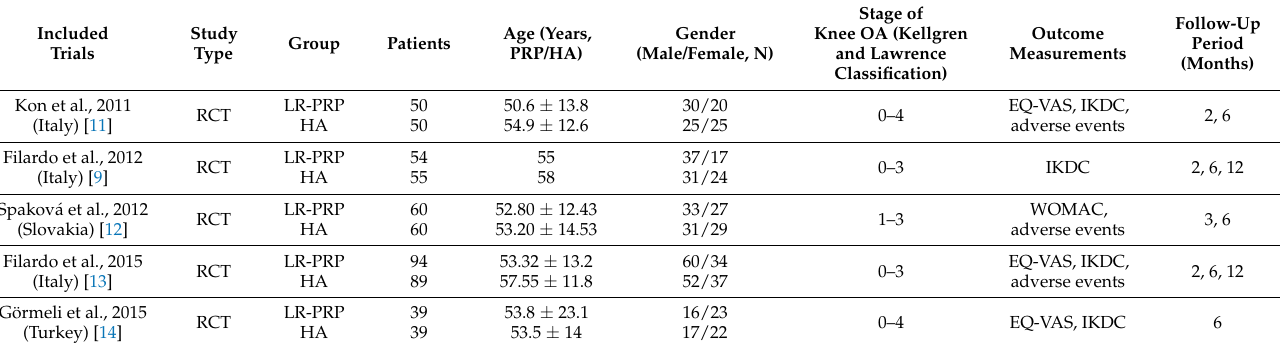
Figure 1. PRISMA flow chart showing literature search and selection process. Table 1. General characteristics of the included